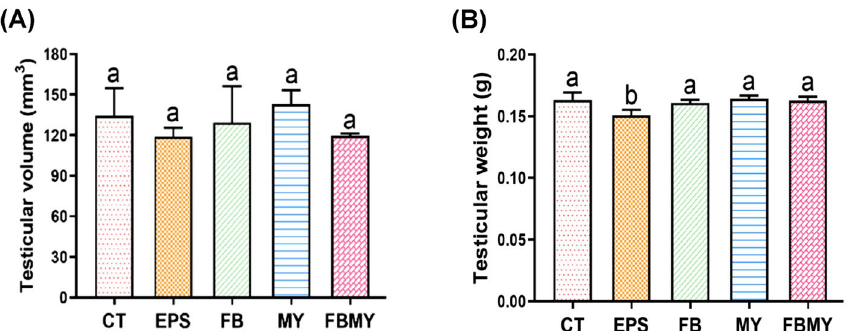
Figure 2. Effects of C. militaris fermentation products on apparent testicular parameters of JM mice. Testicular volumes (A) and testicular weights (B) were shown in different indicated groups. Values are presented as means ± SD (n = 5 for all test groups). Panels marked with different lowercase letters are significantly different ( p <